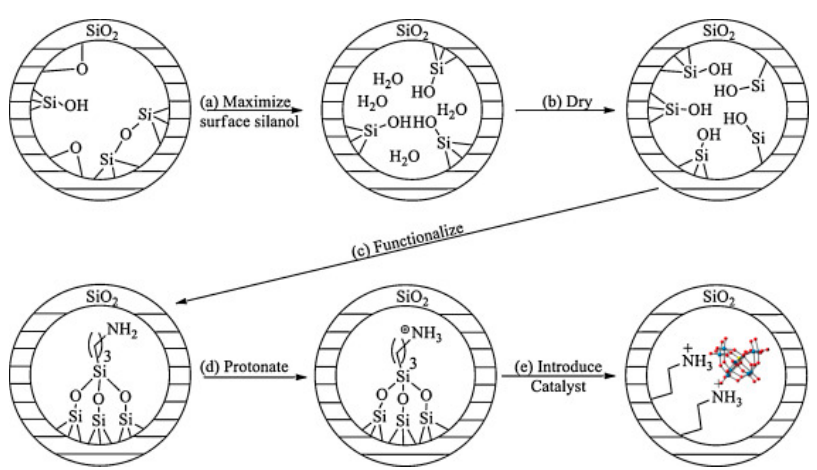
Figure 42. Functionalization and impregnation of MCM-41 silica. Conditions: ( a ) 6 M HCl reflux; ( b ) dried in oven at 100 °C and refluxed in toluene with attached Dean–Stark trap; ( c ) reflux in toluene with APTES; ( d ) suspend in DCM with 2 equiv. HNO 3 ; ( e ) suspend in acetonitrile solution of [ γ -SiW 10 O 34 (H 2 O) 2 ] 4 − . Reproduced with permission from [80]. Copyright 2014 Elsevier B.V.